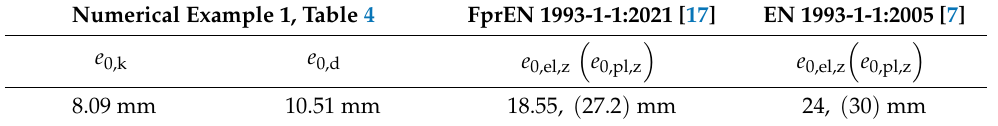
Table 9. Buckling about axis 𝑧 − 𝑧 . Comparison of values 𝑒 (cid:2868), 𝑀 (cid:2889)(cid:2914),(cid:2913)(cid:2893)(cid:2893) , 𝑈 (cid:2893)(cid:2893) and (𝑈 (cid:2897)(cid:2898) ) of the second-or- der analysis.